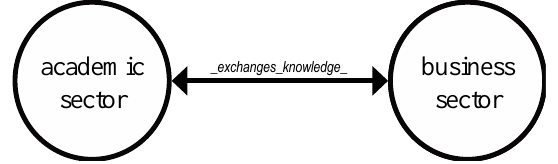
Figure 2. Knowledge exchange between collaborative partners.